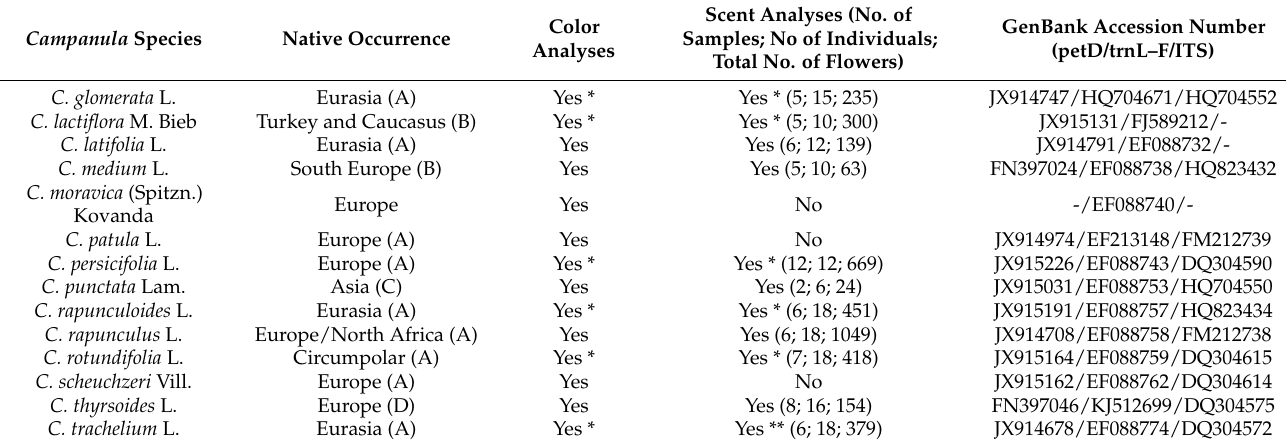
Table 1. List of Campanula species investigated for corolla color reflectance and floral scents, with their respective native occurrence. Number of scent samples and GenBank accession numbers of sequences used for testing phylogenetic patterns are given. For color analyses, N = 3 for all species. References: (A) Rosenbauer [85]; (B) Kovacic [21]; (C) Inoue and Amano [86]; and (D) Kuss et al. [41]. Scent Analyses (No. of Color Samples; No of Individuals; Native Occurrence Analyses Total No. of